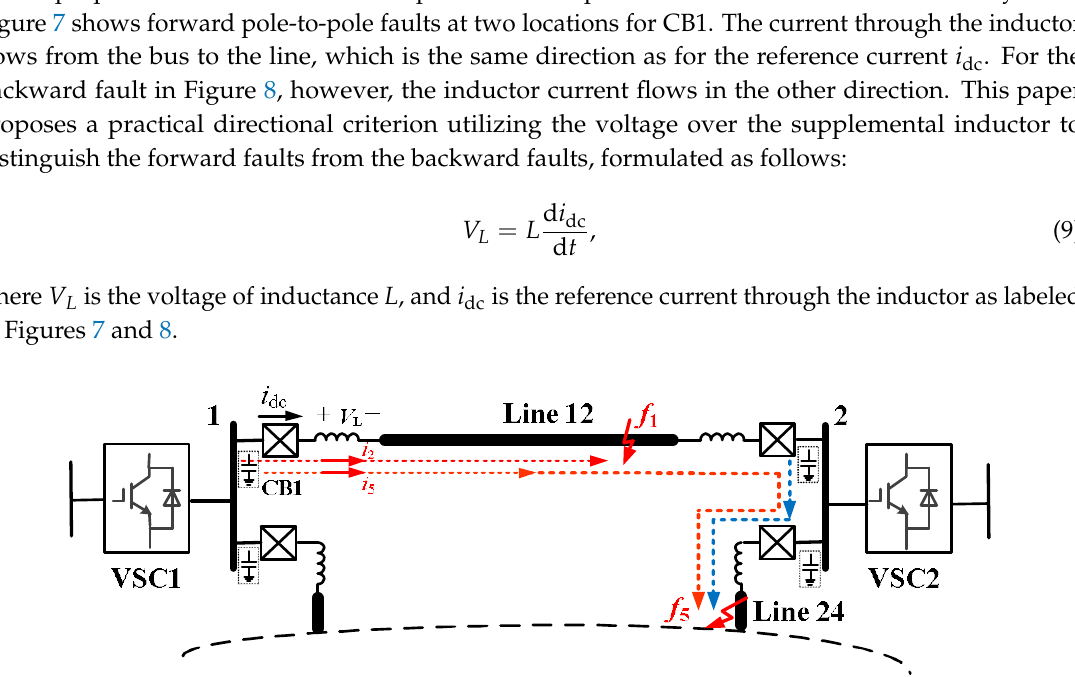
Figure 7. The voltage of inductor for forward faults for CB1 in the multi-terminal system, taking a pole-to-pole fault as an example: f 1 on line 12 and f 5 on line 24. The DC faults i 2 and i 5 suggest the fault current through local sensors at CB1.